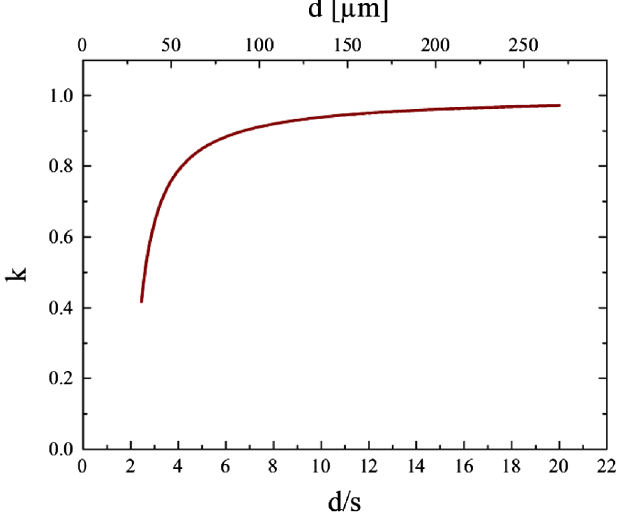
FIG. 4. (a) The beam at the splitting mirror and (b) at the . Because of the propagation detector with an overlap (cid:1) x d ¼ 20 m the beam appears larger distance of L d